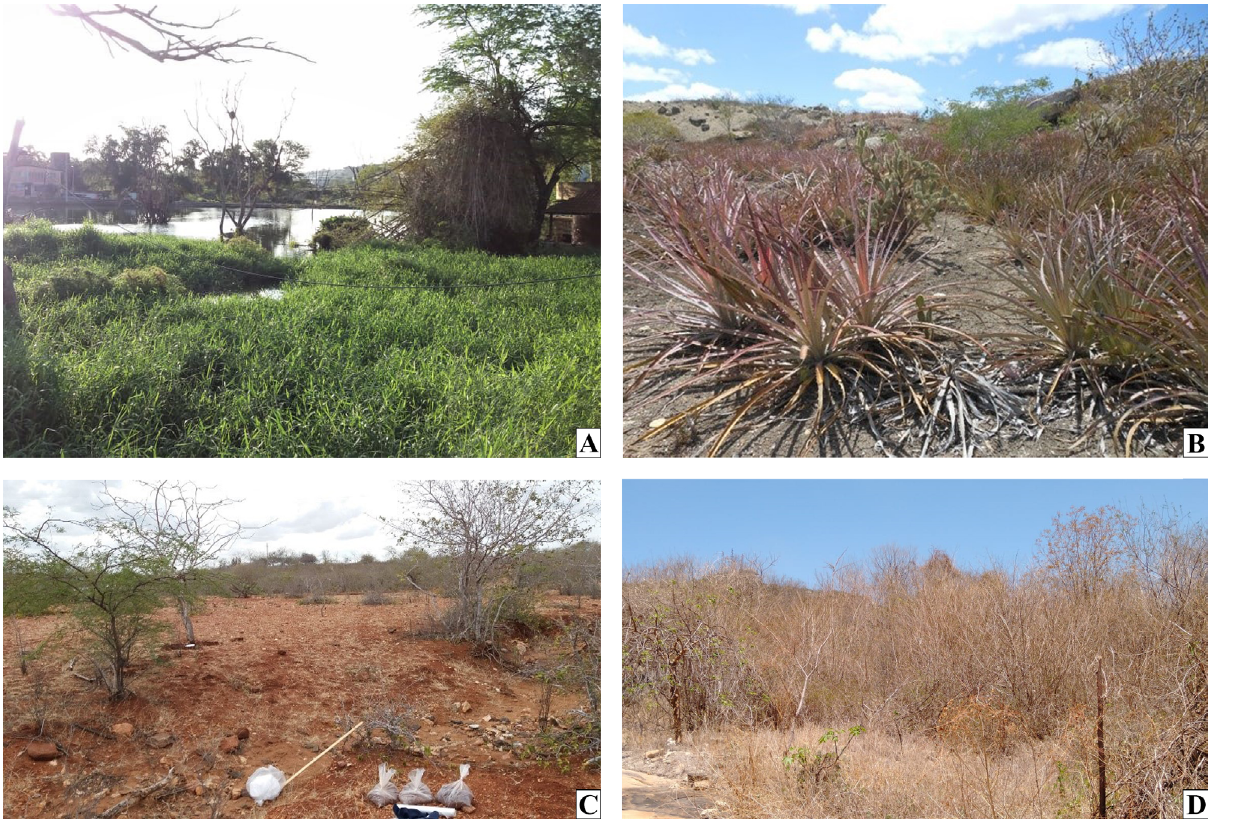
Figure 2. Study area. A , Artificial lake, Campina Grande; B , Caatinga, Campina Grande; C, D , Caatinga, Cabaceiras.